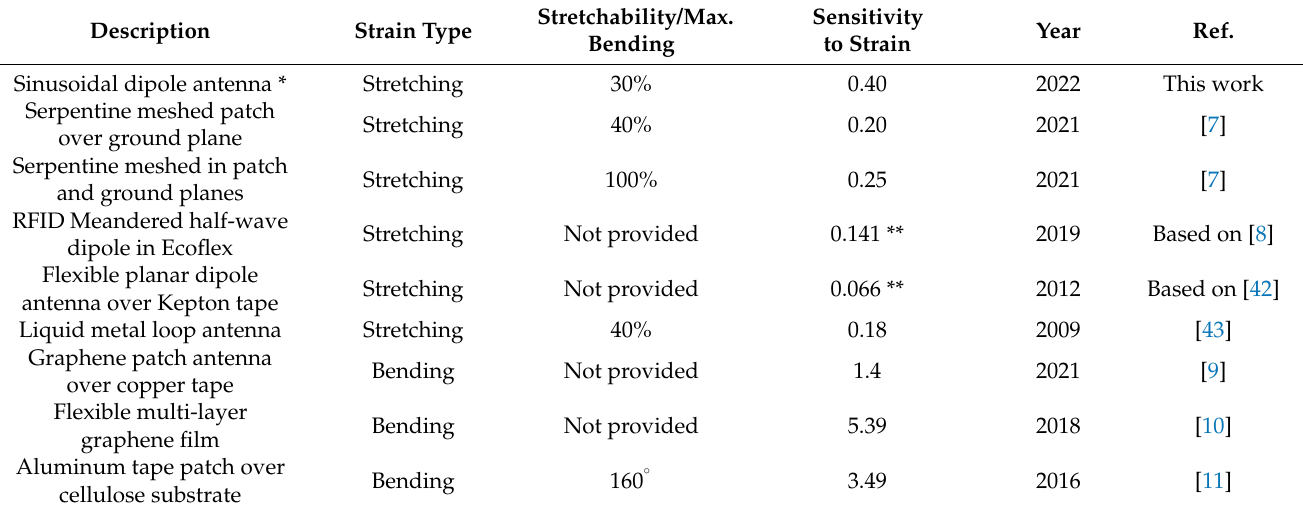
Table 4. Comparison of recent works on stretchable antennas for strain sensing.